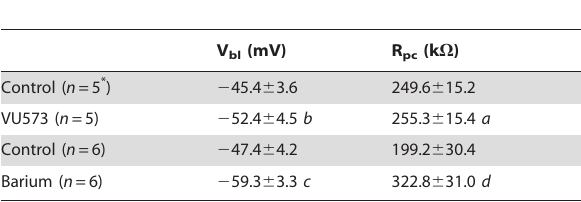
Table 1. Effects of VU573 (10 m M) and barium (5 mM) on the basolateral membrane voltage (V bl ) and input resistance (R pc ) of principal cells in isolated Malpighian